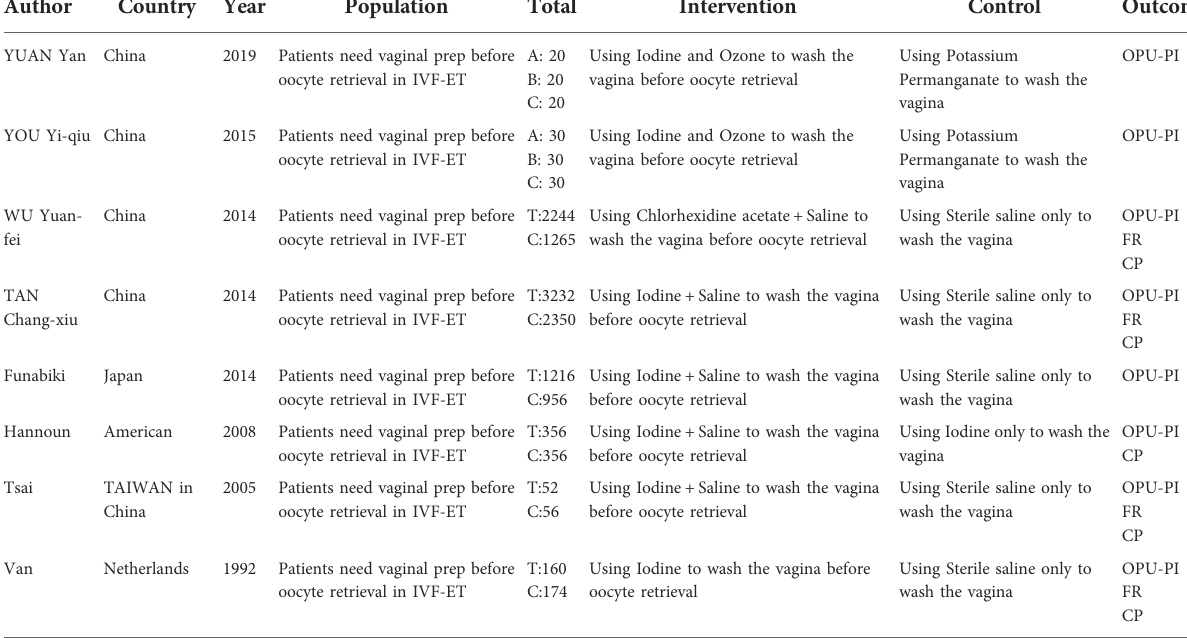
TABLE 2 Characteristics of the studies included in the